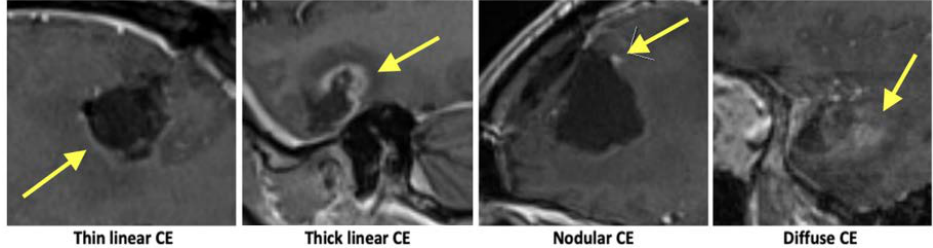
Figure 2. Examples of contrast enhancement. Enhancement patterns are marked with yellow ar- rows.